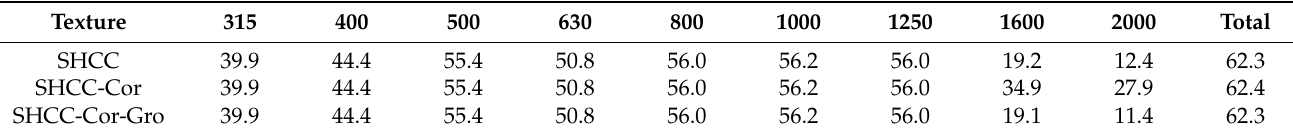
Table 8. Sound level (cavity) for SHCC, modified SHCC-Cor, and SHCC-Cor-Gro.